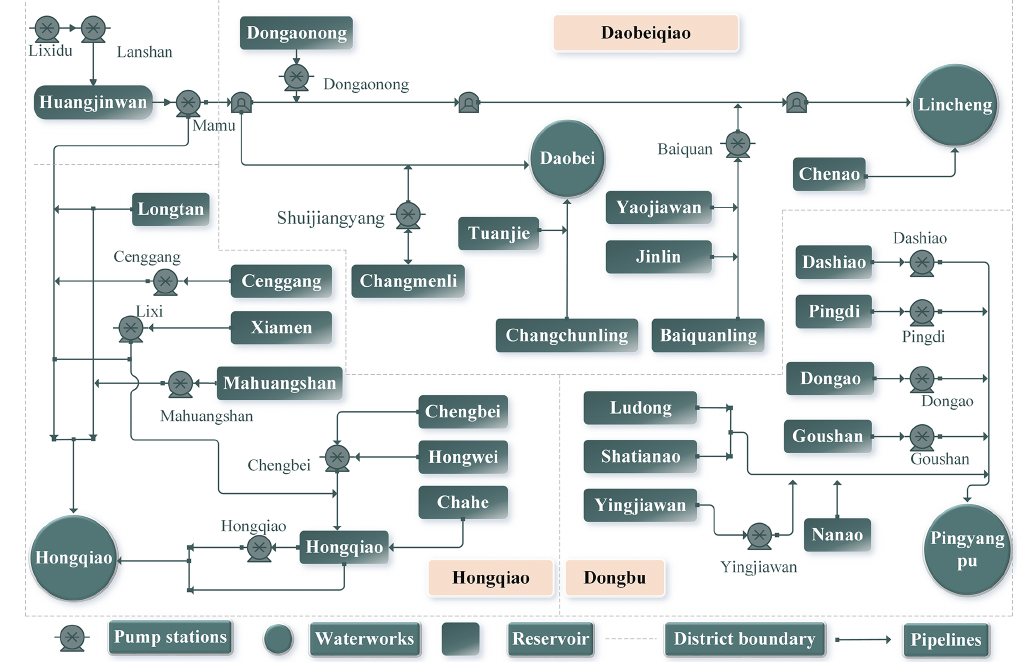
Figure 5. Schematic diagram of the Zhoushan